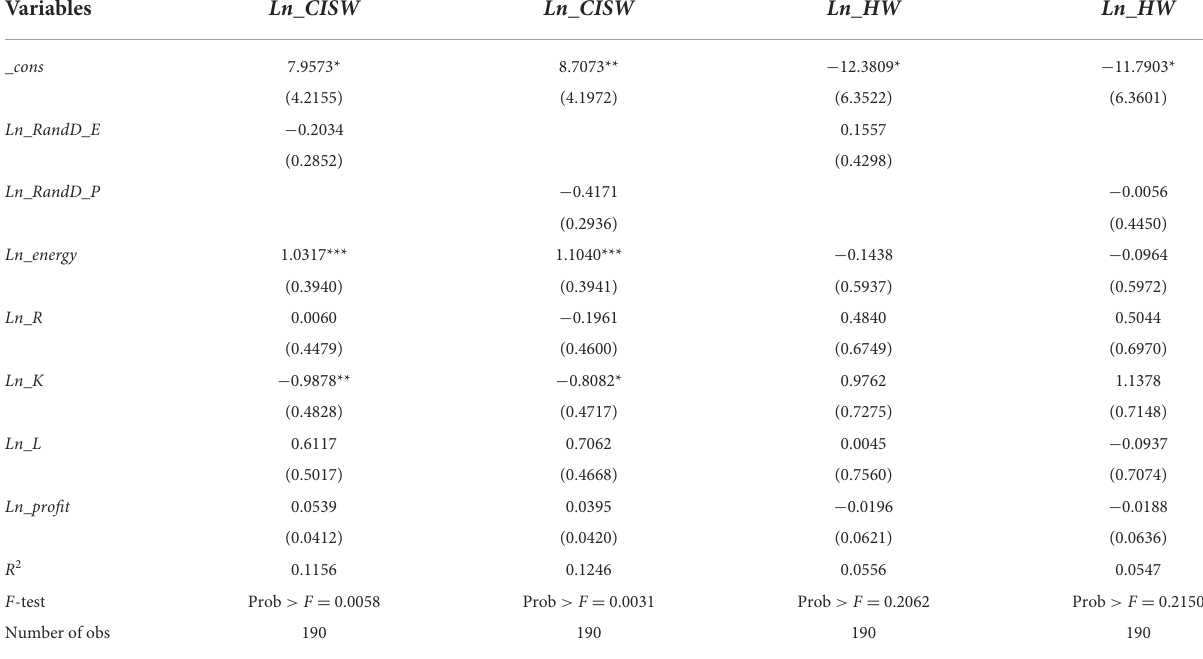
TABLE 4 Nexus between research and development (RandD) activities and industrial solid